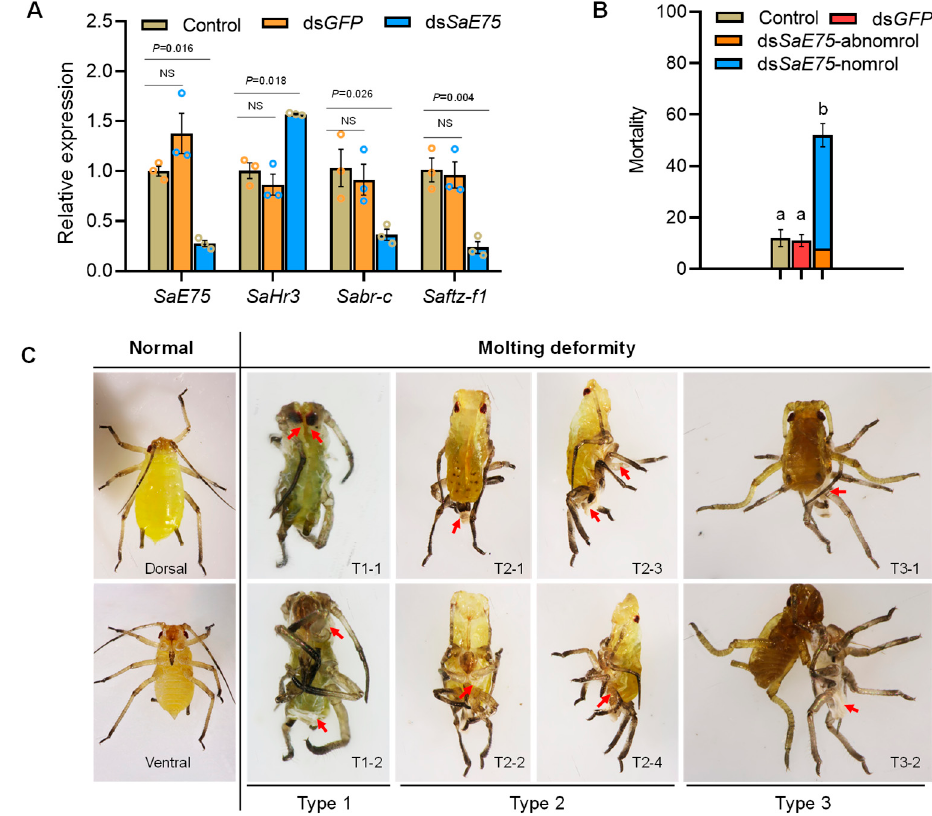
Figure 4. Functional analysis of SaE75 . Data shown for ds SaE75 with respect to ( A ) the expression level of SaE75 and downstream genes ( Sabr-c , SaHr3 and Saftz-f1 ), and ( B ) mortality. ( C ) Phenotypic impacts of ds SaE75 on S. avenae molting. ds SaE75 -normal: aphids dead without any detectable morphological abnormality; ds SaE75 -abnormal: aphids dead with molting deformed; T1-1 and T1-2: dorsal view and ventral view of “unable to molt” phenotype; T2-1 to T2-4: dorsal view, ventral view, and side view of “partial molt” phenotype; T3-1 and T3-2: dorsal view and ventral view of “almost finished molt” phenotype. Red arrow shows the position of molting deformity. Expression differences of four genes among control, ds GFP , and ds SaE75 groups were tested using one-way ANOVA followed by Tukey’s tests. Different color circle represents three replications of experiment. Different letters (a, b) indicate significant differences between means ( p < 0.05). Red arrows represent the location of abnormal molting. Error bars represent means ± SD. The p values indicate significant differences, and NS means not